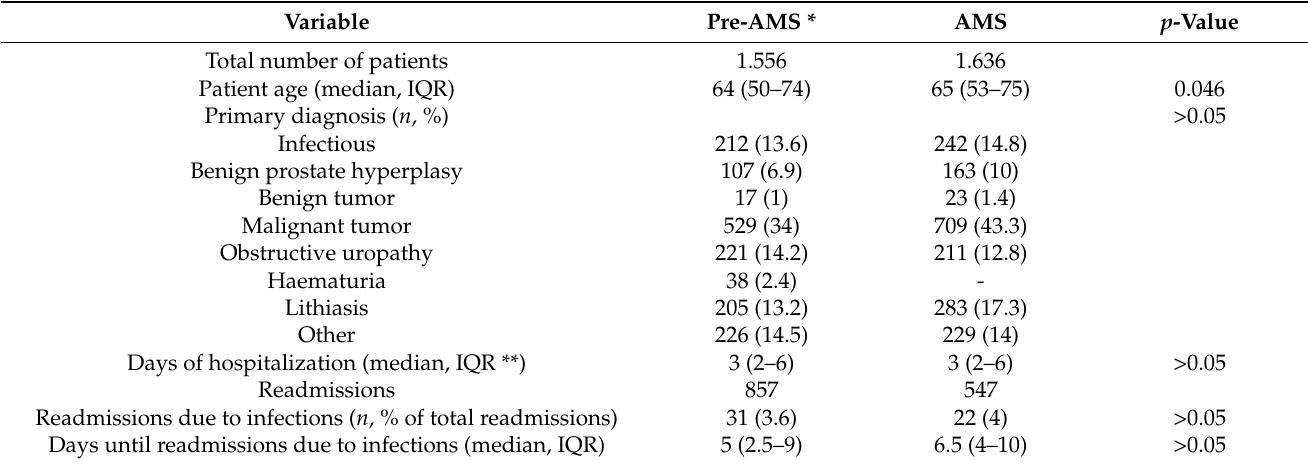
Table 1. Patients‘